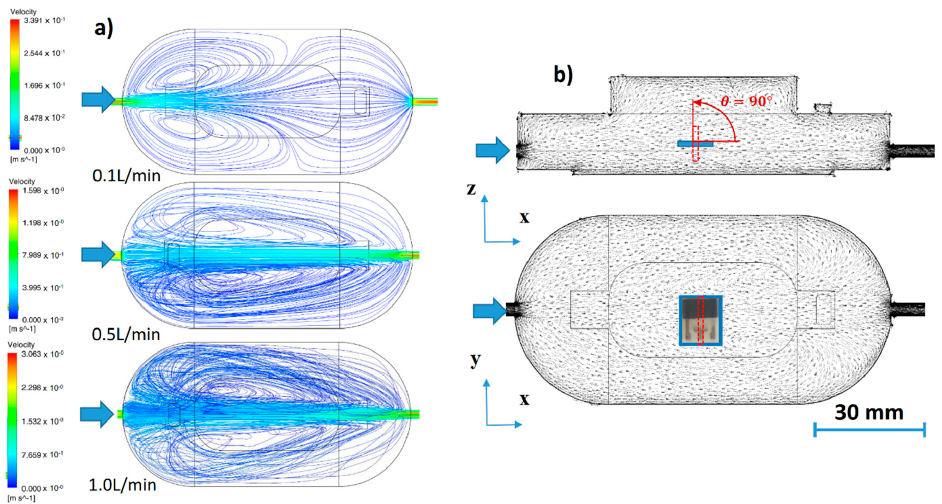
Figure 2. ( a ) Computational fluid dynamics (CFD) simulations of airflow in the test chamber at flow rates 0.1 L / min, 0.5 L / min and 1.0 L / min, ( b ) sensor position and orientation towards the flow at angle 0 ◦ and 90 ◦ in the gas